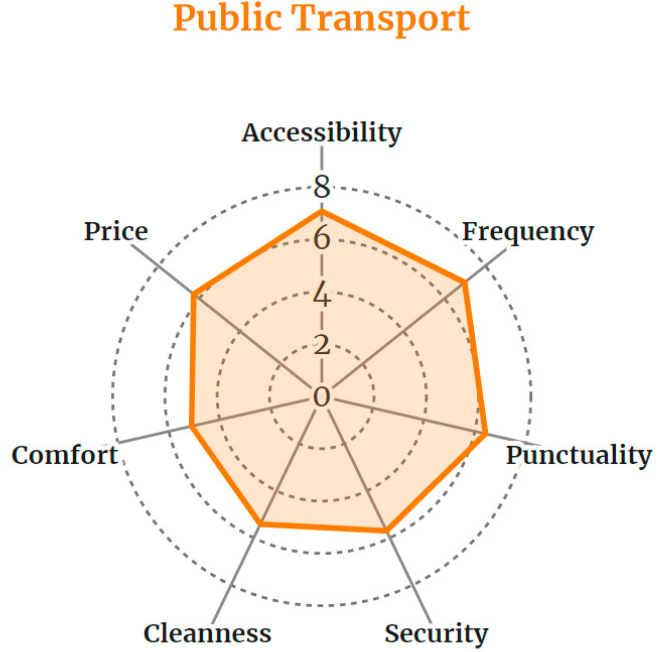
Figure 3. Assessment of public transportation conditions in the Dominican Republic.